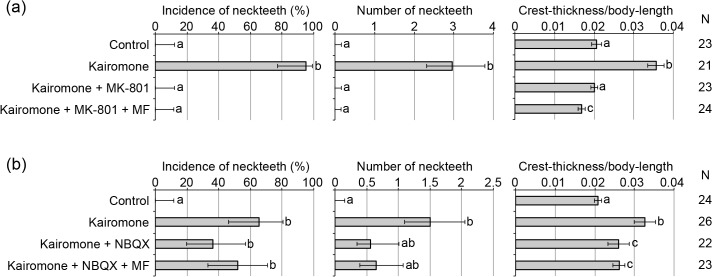
Effect of coexposure of methyl farnesoate (MF) and MK-801 (a) or NBQX (b) on the three different indicators of defensive morph.The indicators are incidence of neckteeth (left), average number of neckteeth (center), and crest thickness normalized to body-length (right). Kairomone (x1/16) was used for neckteeth induction. The final concentrations of chemicals used in this experiment were as follows: 10 μM of MK-801; 100 μM of NBQX; 100 μg/L (400 nM) of MF. Error bars indicate 95% confidence intervals. Different letters indicate significant differences (p < 0.01). N: number of specimens.